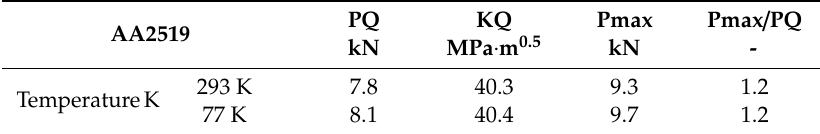
Table 3. Results of fracture toughness tests in a linear-elastic range for AA2519 aluminum alloy under cryogenic conditions.